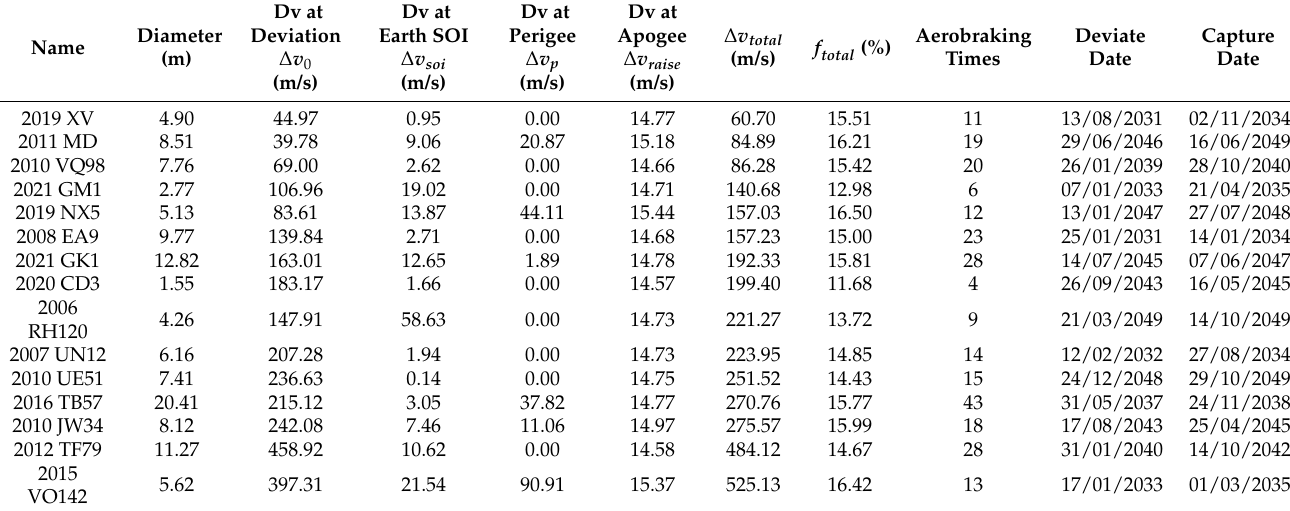
Table 5. Optimization results of Earth aerobraking capture